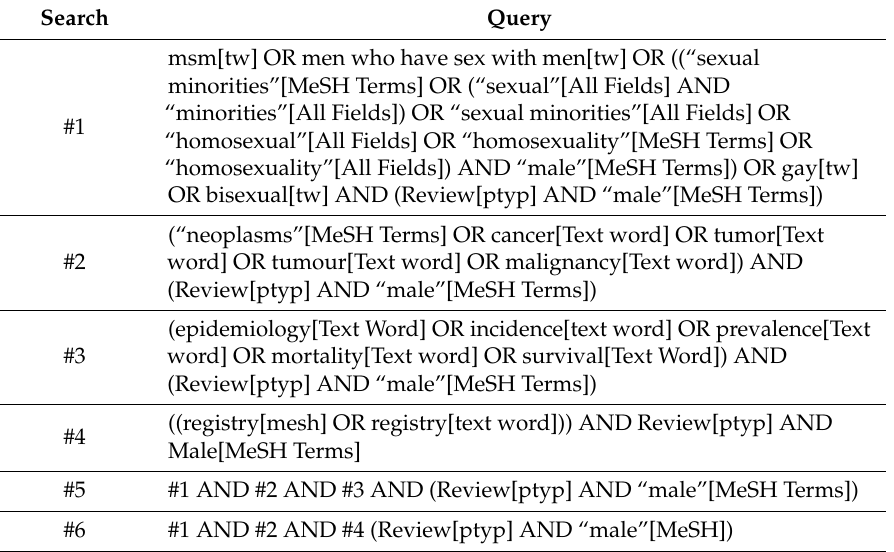
Table 3. Potential Search Strategy Using Medline on